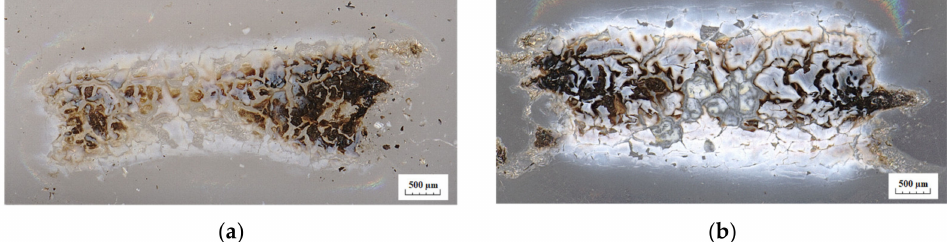
Figure 10. Surface residue of ( a ) the SiR + 30 wt% GS10 and ( b ) SiR + 5 wt%FS07 composites tested using the dry-arc resistance test for the first 10 s of cycle